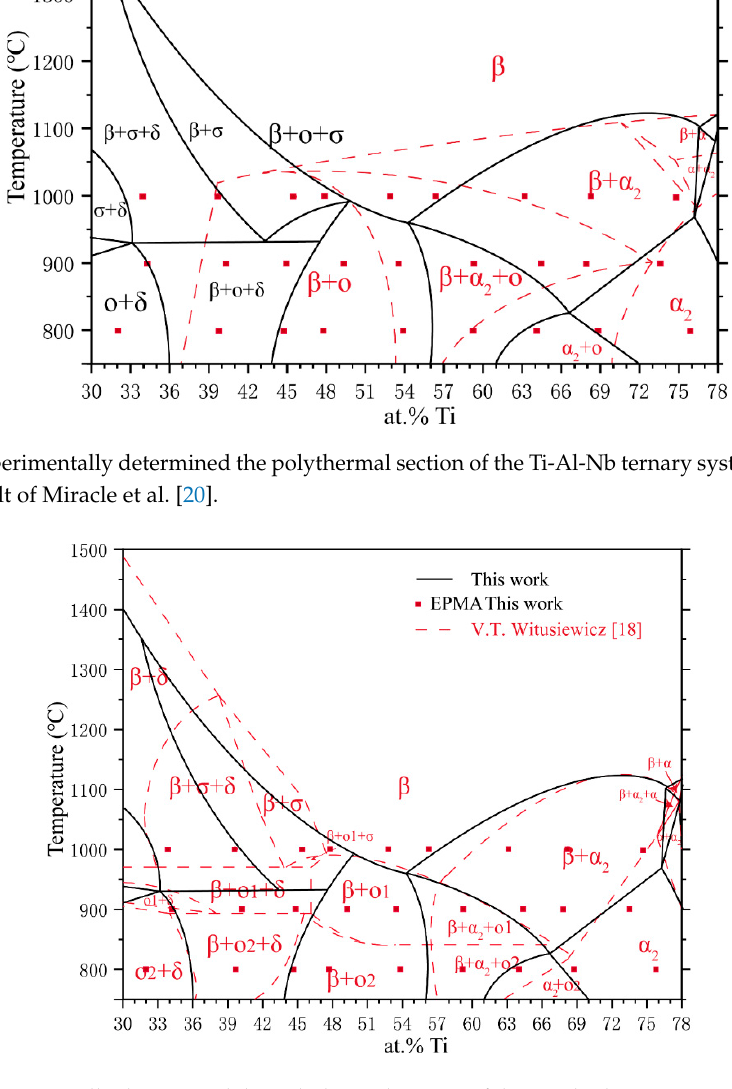
Figure 9. Experimentally determined the polythermal section of the Ti-Al-Nb ternary system compared with the calculated results of Witusiewicz et al. [18] .